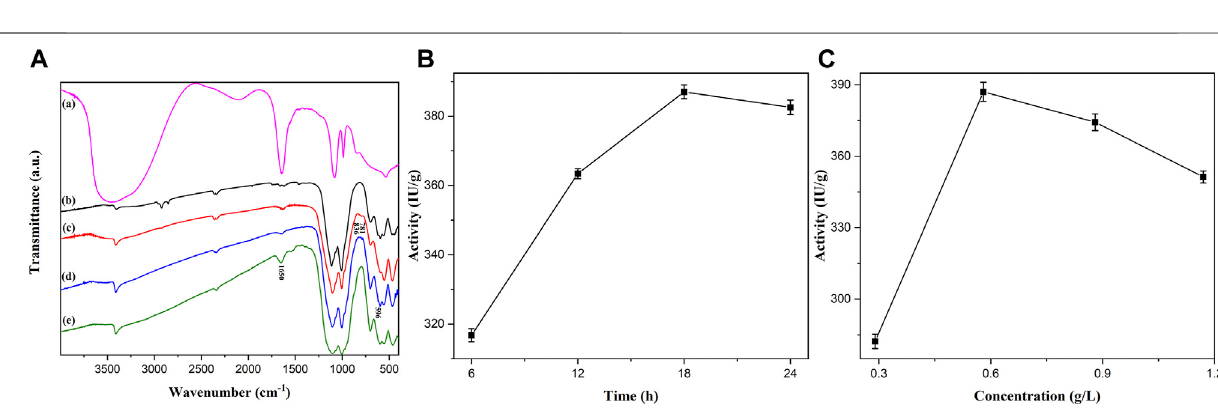
Frontiers in Bioengineering and Biotechnology |